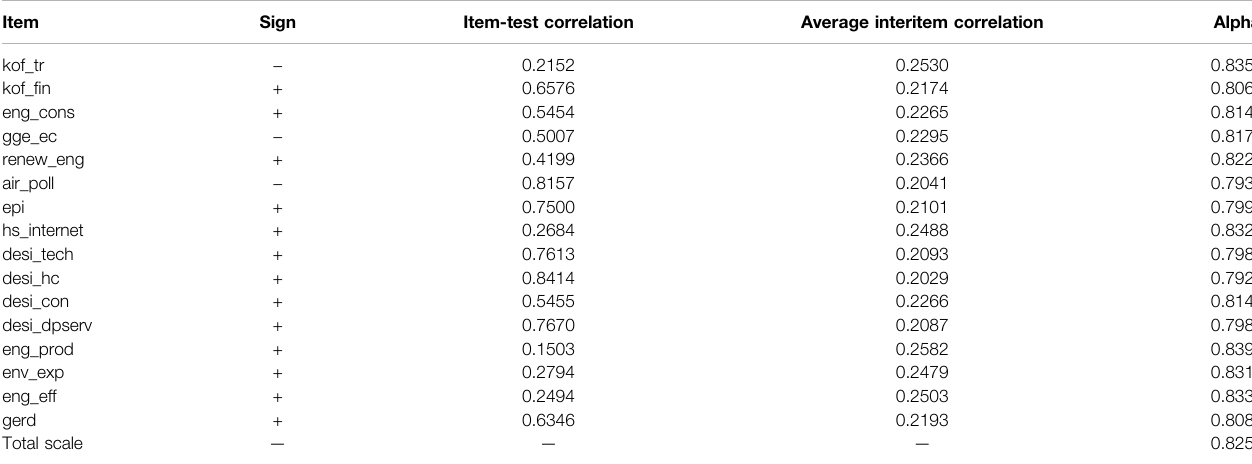
TABLE 3 | Cronbach ’ s alpha for the SEM model.